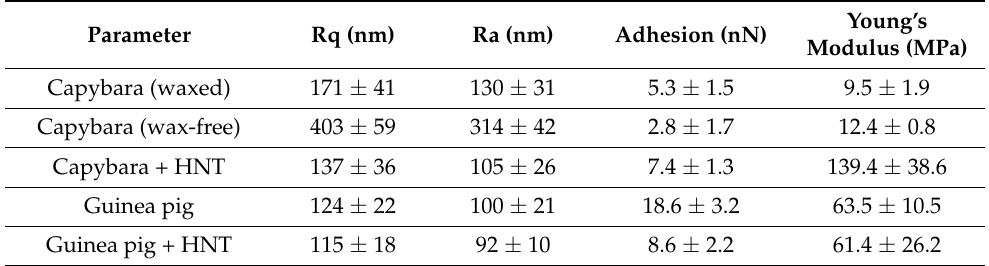
Table 2. Capybara and guinea pig hair cuticle AFM surface roughness and mechanical properties.